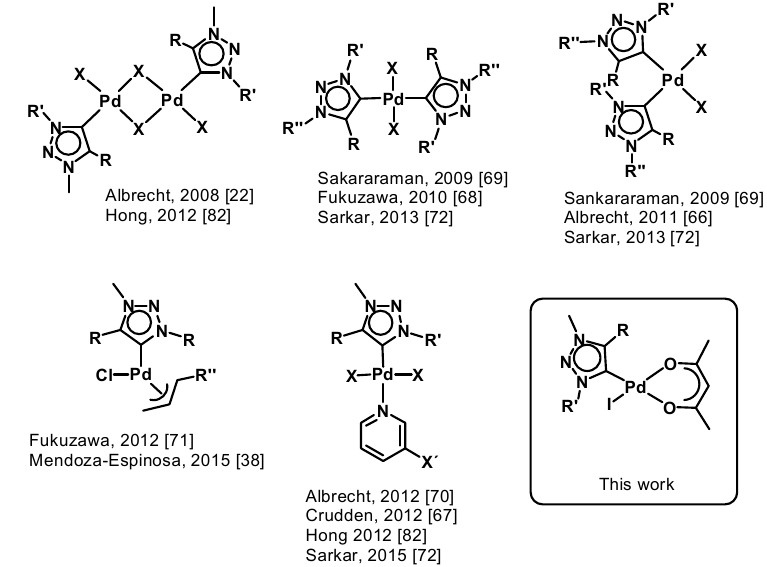
Figure 1. Overview of selected palladium( II ) complexes with 1,2,3-triazol-5-ylidene ligands.